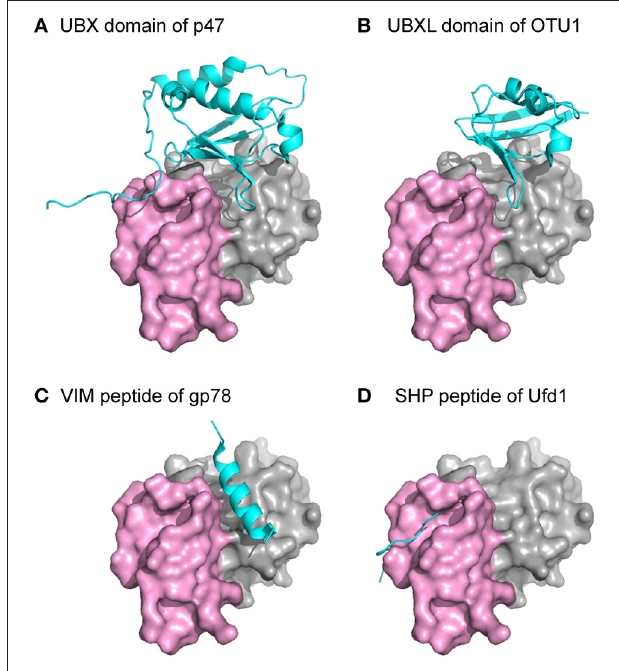
FIGURE 4 | Structures of p97 in complex with interacting proteins. The N domain of p97 is shown as a surface representation with the two subdomains, double ψ -barrel and β -barrel, in gray and violet, respectively. Individual domains or peptides from different p97-interacting proteins are shown as a cyan cartoon. All the structures were superposed with the N domain of p97 and presented in the same orientation. (A) PDB:1S3S ( Dreveny et al., 2004). (B) PDB:4KDI (Kim et al., 2014). (C) PDB:3TIW (Hänzelmann and Schindelin, 2011 ). (D) PDB:5C1B (Hänzelmann and Schindelin,